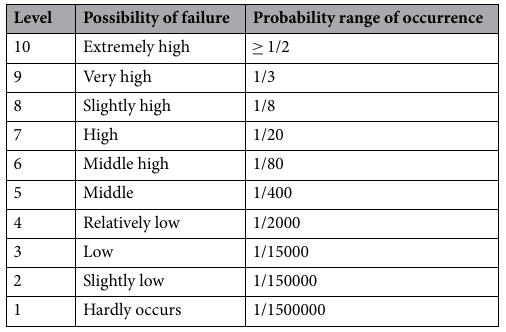
Table 1. Classification of failure mode occurrence